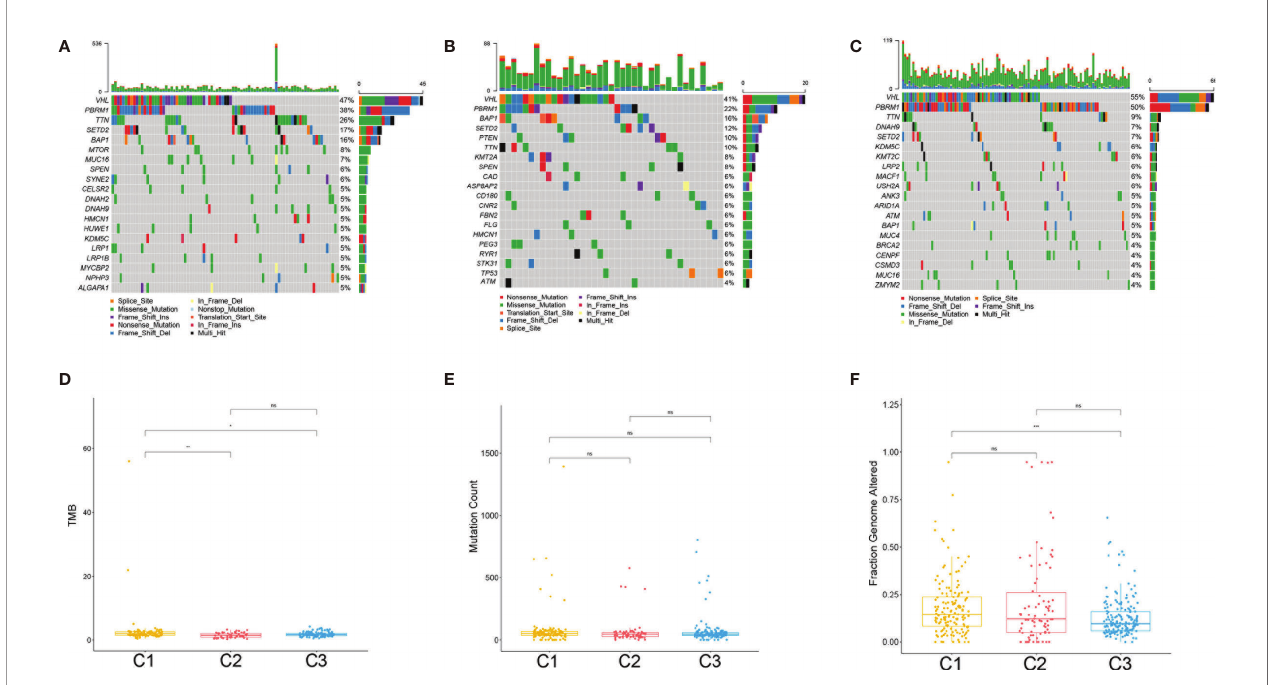
FIGURE 6 | Association between the clear cell renal cell carcinoma (ccRCC) subclasses and mutations. (A – C) Oncoprint of the mutation status of the top 20 genes in subclasses C1(SC_E), C2(SC_A), C3(SC_D). (D – F) The tumor mutation burden (D) , mutation count (E) , and fraction genome altered (F) in the three subclasses. ns , no signi fi cance. * p < 0.05, ** p < 0.01, *** p < 0.001.